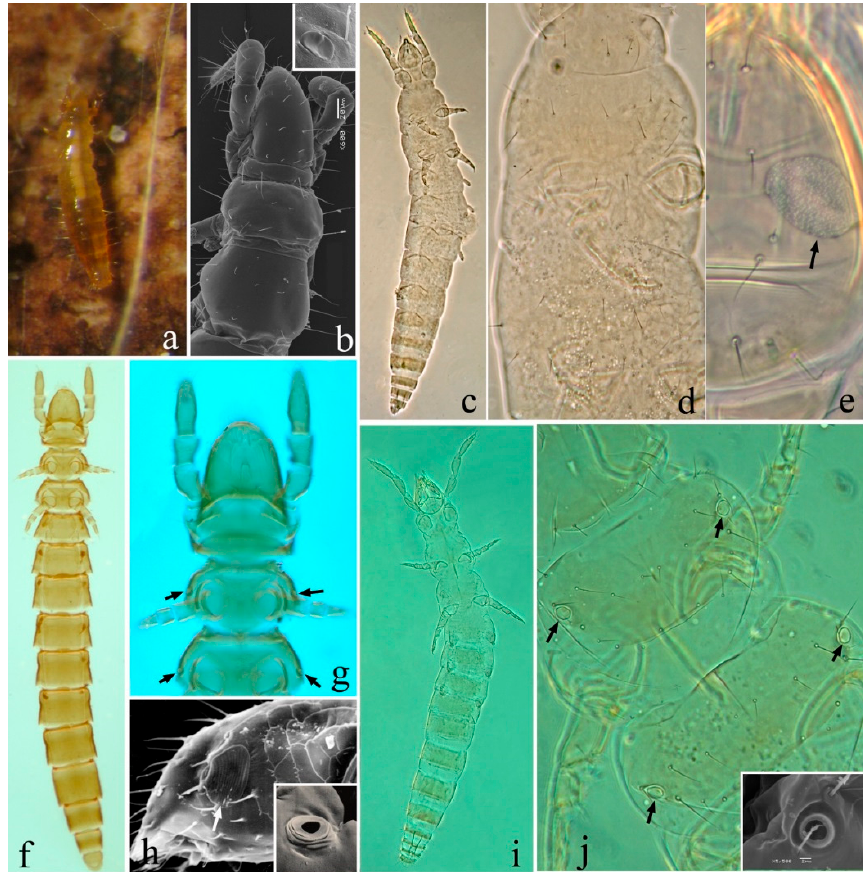
Figure 1. Morphology of Protura. ( a , b ) Acerentomata: Acerentomidae ( sensu [2]). ( a ) Acerentomon microrhinus , ( b ) dorsal view of Baculentulus tianmushanensis and pseudoculus (inset); ( c – e ) Fujientomon dicestum (Sinentomata: Fujientomidae), c. whole body, ( d ) dorsal view of thorax showing notum, ( e ) right side of head, large pseudoculus (arrow); ( f – h ) Sinentomon erythranum (Sinentomata: Sinentomidae). ( f ) whole body, ( g ) dorsal view showing notum and spiracles (arrows) ( h ) lateral view of head showing large pseudoculus (arrow) and spiracle (inset); ( i , j ) Eosentomon sakura (Eosentomata: Eosentomidae). ( i ) ventral view, ( j ) dorsal view of thorax with spiracles (arrows), inset shows detail of spiracle.